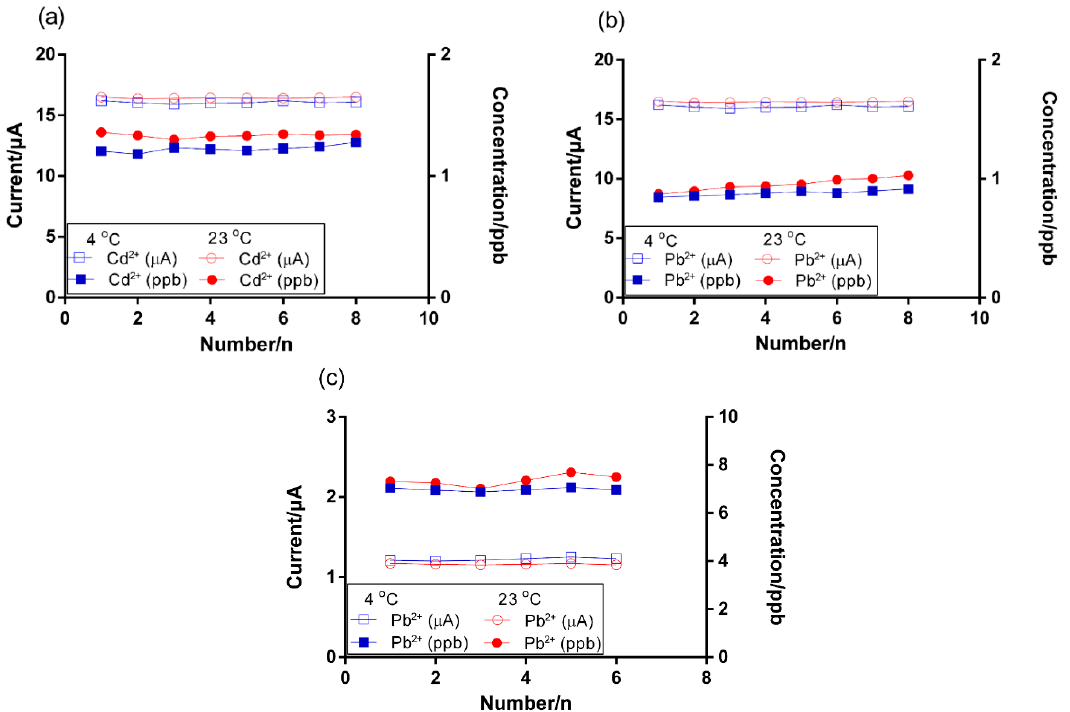
Figure 8. The reproducibility of heavy metal detection under different temperatures of ( a ) Cd 2+ and ( b ) Pb 2+ in a mining wastewater sample, and ( c ) Pb 2+ in a soil leachate sample using the Bi/chitosan-coated carbon electrode.